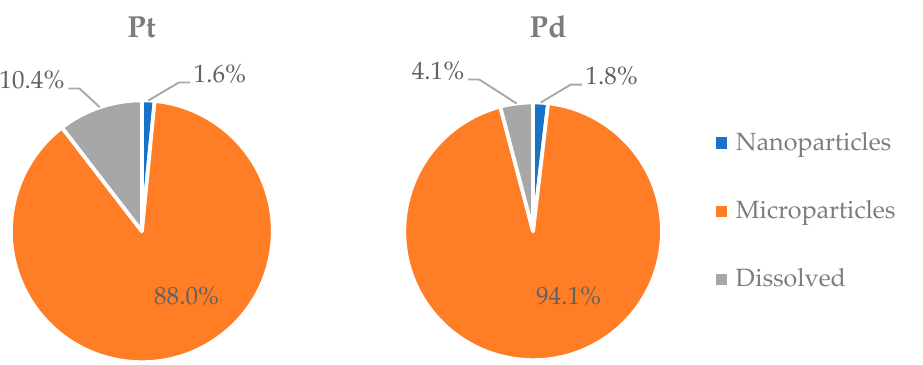
Figure 3. Distribution of Pt and Pd between nanoparticulate, microparticulate, and dissolved fractions of road dust.